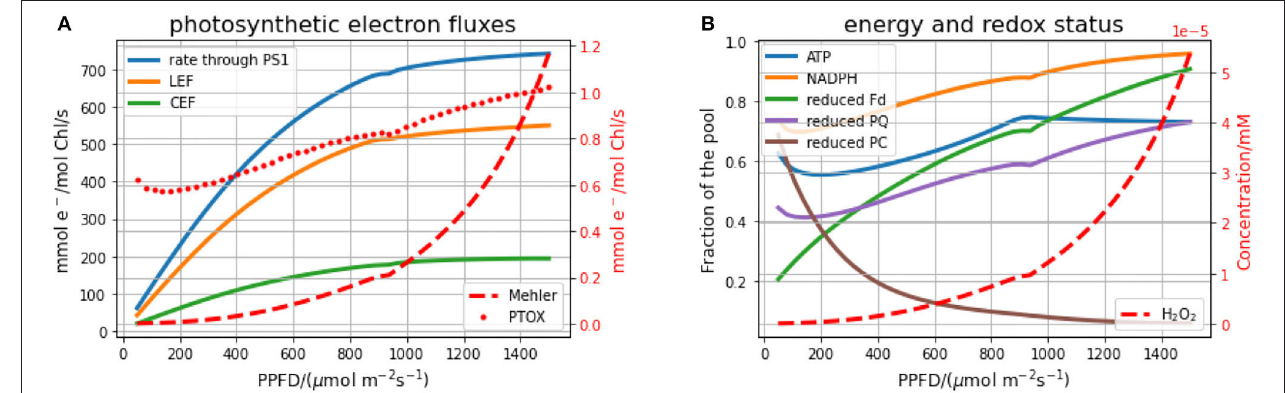
FIGURE 3 | Stationary fluxes and stationary energy and redox status of the electron transport chain for different intensities of constant light. (A) displays the electron flux through PSI, linear (LEF) and cyclic electron flow (CEF), the Mehler reaction and the plastid terminal oxidase (PTOX). (B) displays the energy equivalents (ATP, NADPH) and redox states of the electron chain (PQ, PC, Fd), as well as the stationary H 2 O 2 concentration resulting from the Mehler